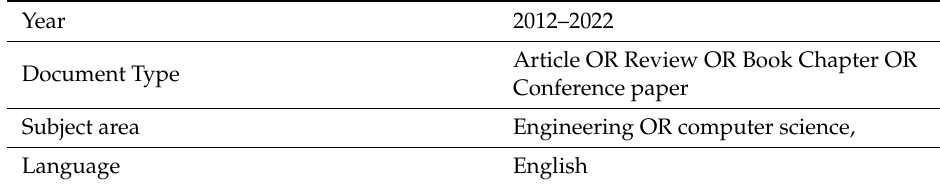
Table 3. Inclusion criteria for explorative literature